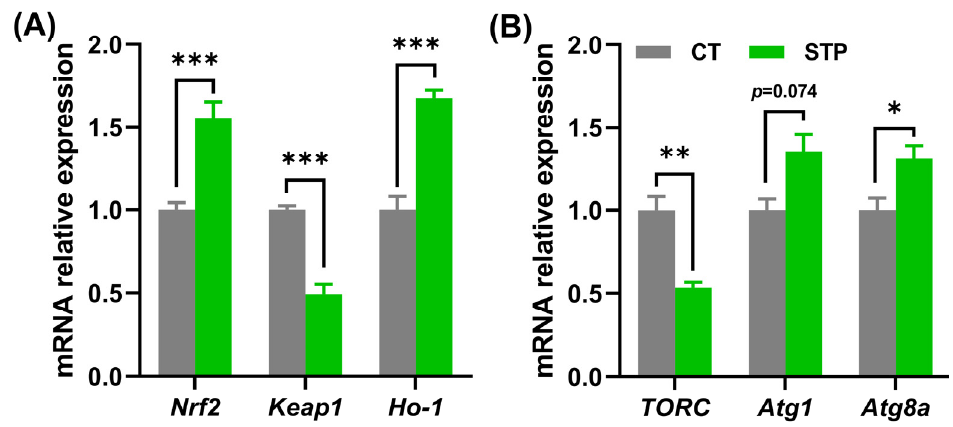
Figure 4. STP may inhibit the TOR signaling pathway to prolong the lifespan of flies. The gene expression level of ( A ) Nrf2 , Keap1 , and Ho-1 ; ( B ) TORC , Atg1 , and Atg8a . Data are shown as mean ± SEM. Statistical test: two-tailed unpaired t -test (* p < 0.05, ** p < 0.01, and *** p < 0.001 vs. CT group).